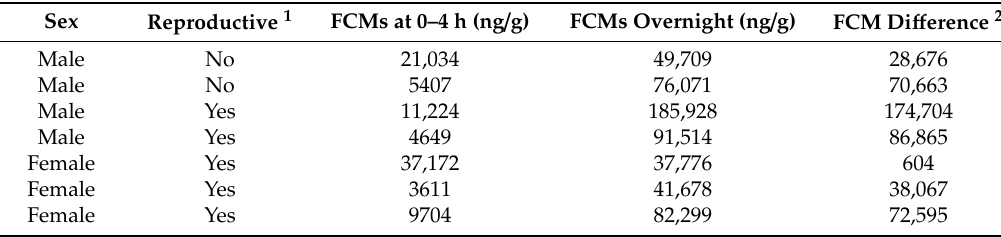
Figure 5. Fecal cortisol/corticosterone metabolites (FCMs) across different trap confinement times in free-ranging deermice. FCMs were measured with the group-specific EIA. Boxplots display the median (line), 25–75% interquartile range (boxes) and the full range (whiskers). In the 0–2 h group, there is a large outlier. Circles indicate individual data points whereby blue denotes males and red denotes females. Table 2. Summary of demographic factors and fecal cortisol/corticosterone metabolite (FCM) values from free-ranging deermice captured in MT, USA in August 2017 for field study 2.